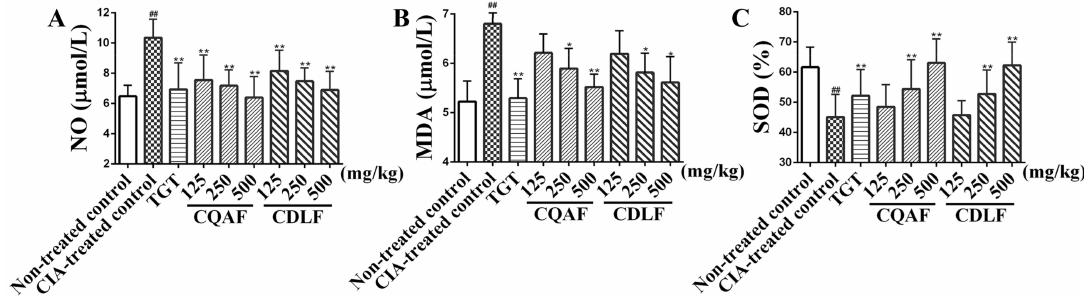
Figure 5. Effects of CDLF and CQAF on serum NO, MDA, and SOD in CIA rats. ( A ) NO; ( B ) MDA; ( C ) SOD. The data are presented as the mean ± SD ( n = 8). ## p < 0.01 when compared with non-treated control group; * p < 0.05, ** p < 0.01 when compared with CIA-treated control group. Numeric data can be found in Supplementary Materials Table S4.